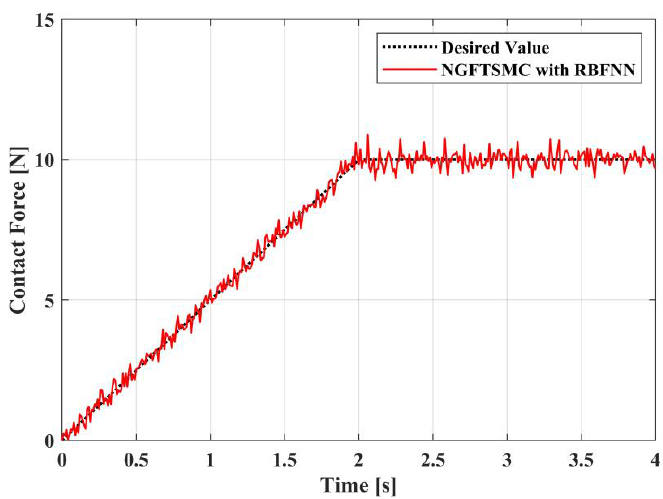
Figure 22. The experimental results in yaw angel.